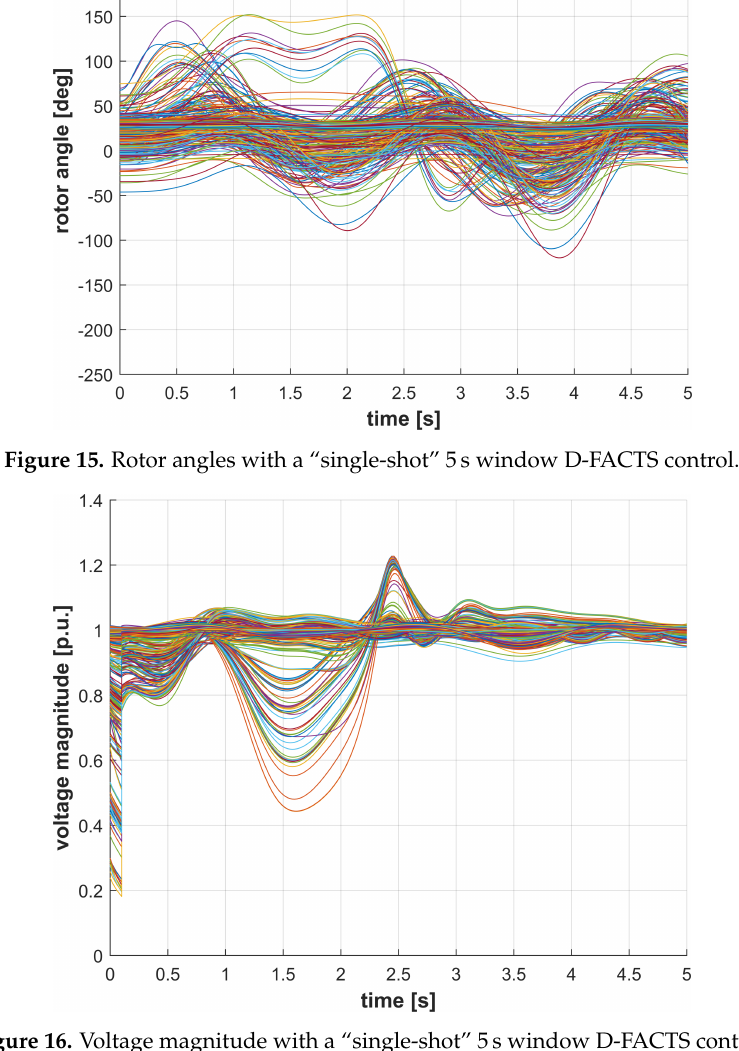
Figure 16. Voltage magnitude with a “single-shot” 5s window D-FACTS